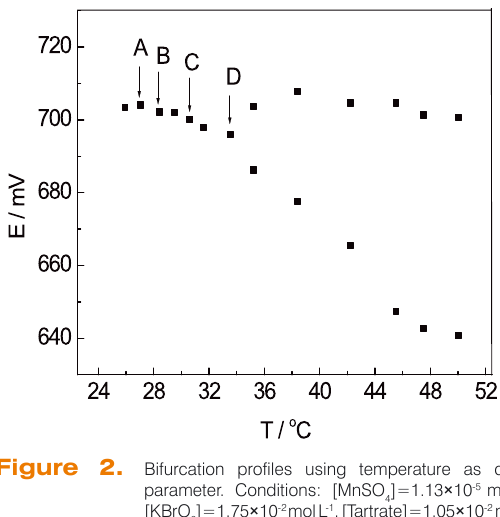
]=1.13 × 10 -5 mol L -1 , 4